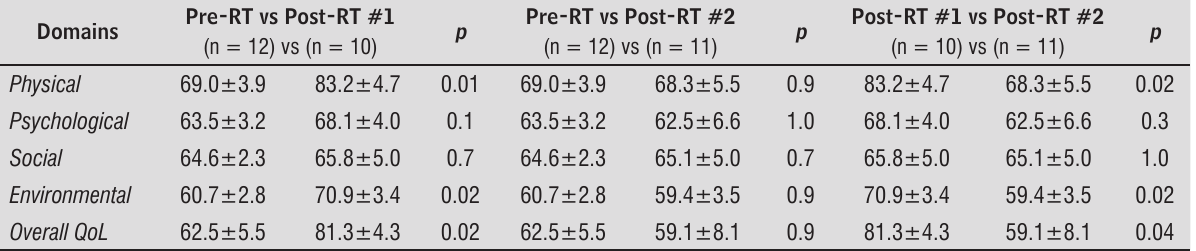
Table 5 - Analysis of WHOQOL-BREF questionnaire [ mean ± SD ]